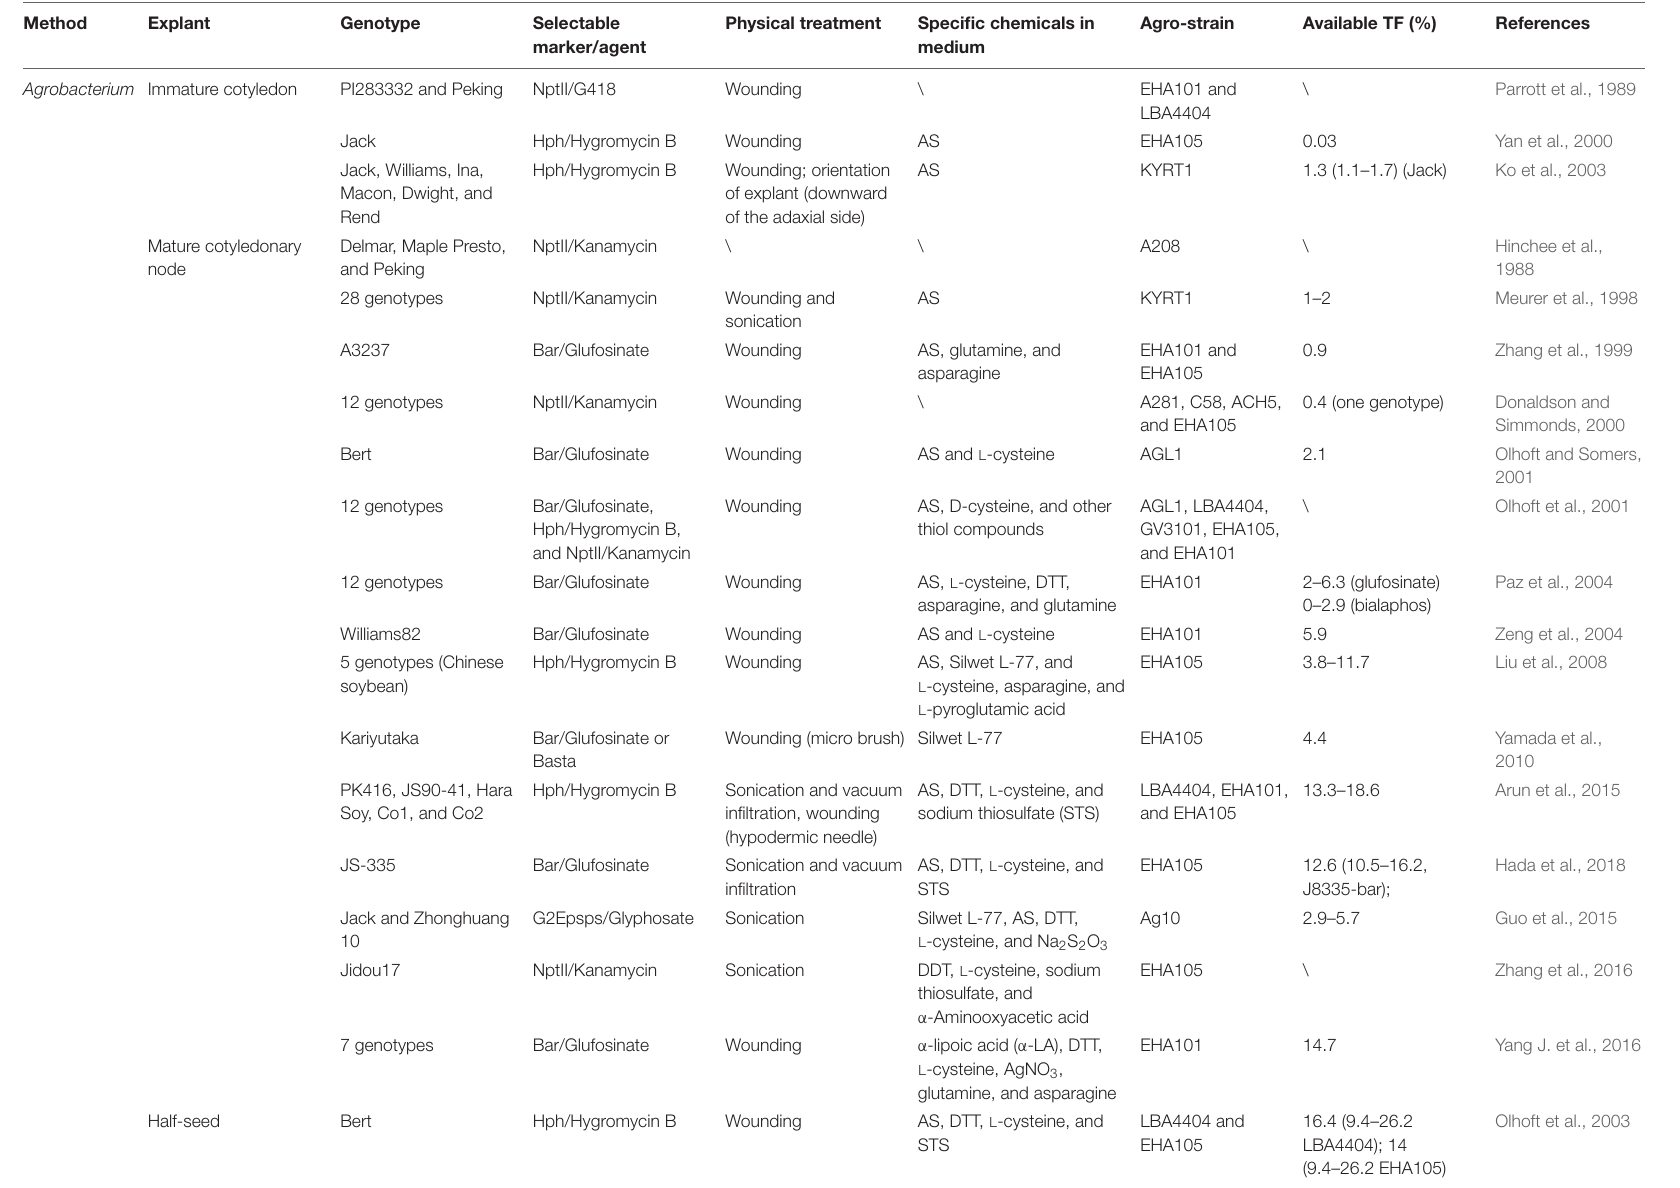
TABLE 1 | Progress of soybean stable genetic transformation approaches for whole transgenic